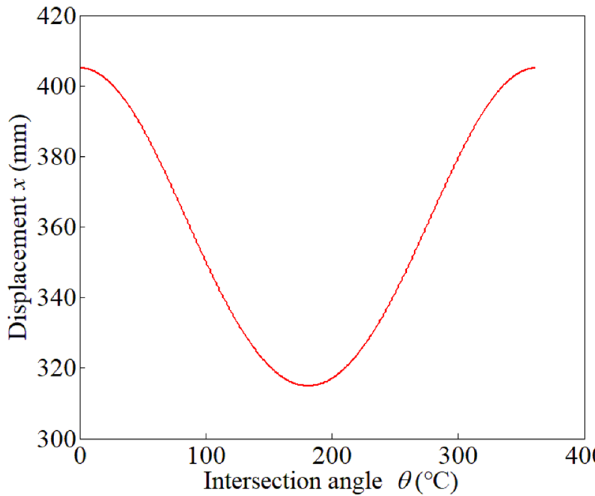
Fig. 4. Displacement of slider in a circle.